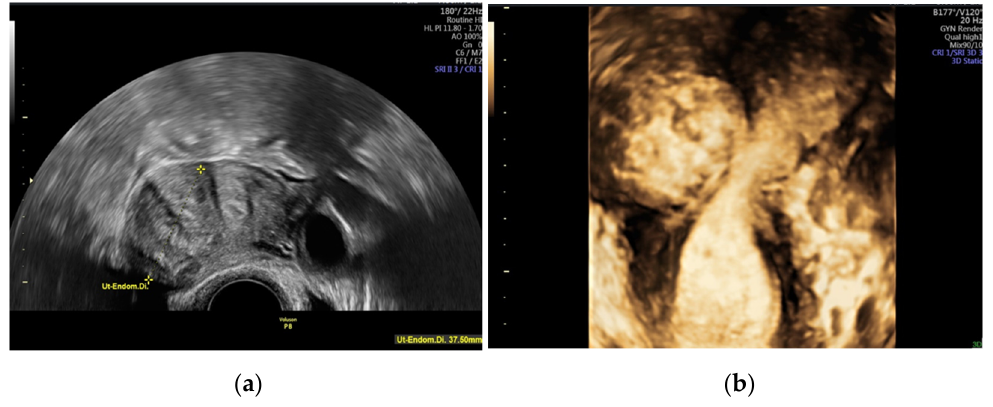
Figure 4. Presentation of an intramural myoma, affecting the cavum uteri, ( a ) with regular 2D vaginal ultrasound on the left-hand side and ( b ) with 3D vaginal ultrasound on the right-hand side. On ultrasound examination, a uterine fibroid is typically seen as a well-defined round lesion within the myometrium or belonging to it, frequently with shadows at the edge or an internal fan-shaped shadow [49]. Doppler ultrasound reveals circumferential flow around the fibroid, called “ring of fire” [35]. Fibroids are usually hypoechoic or isoechoic. The echogenicity varies, depending on the level of calcification and the quantity of fibrous tissue. Sometimes a fibroid has anechoic components due to advancing necrosis. The size of the fibroid is estimated by measuring its three largest orthogonal diameters. Additionally, the minimum distance from the fibroid to the serosal surface and the endometrium of the uterus is measured